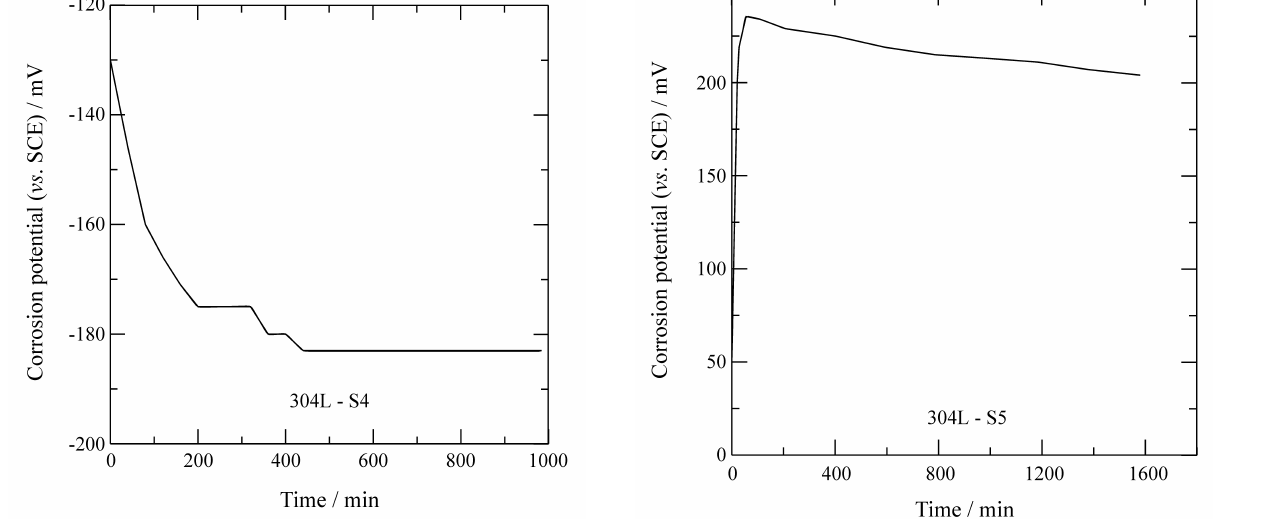
Figure 9. Corrosion potential E corr variation with immersion time in 3.5% NaCl solution for 304L steel with S5 surface